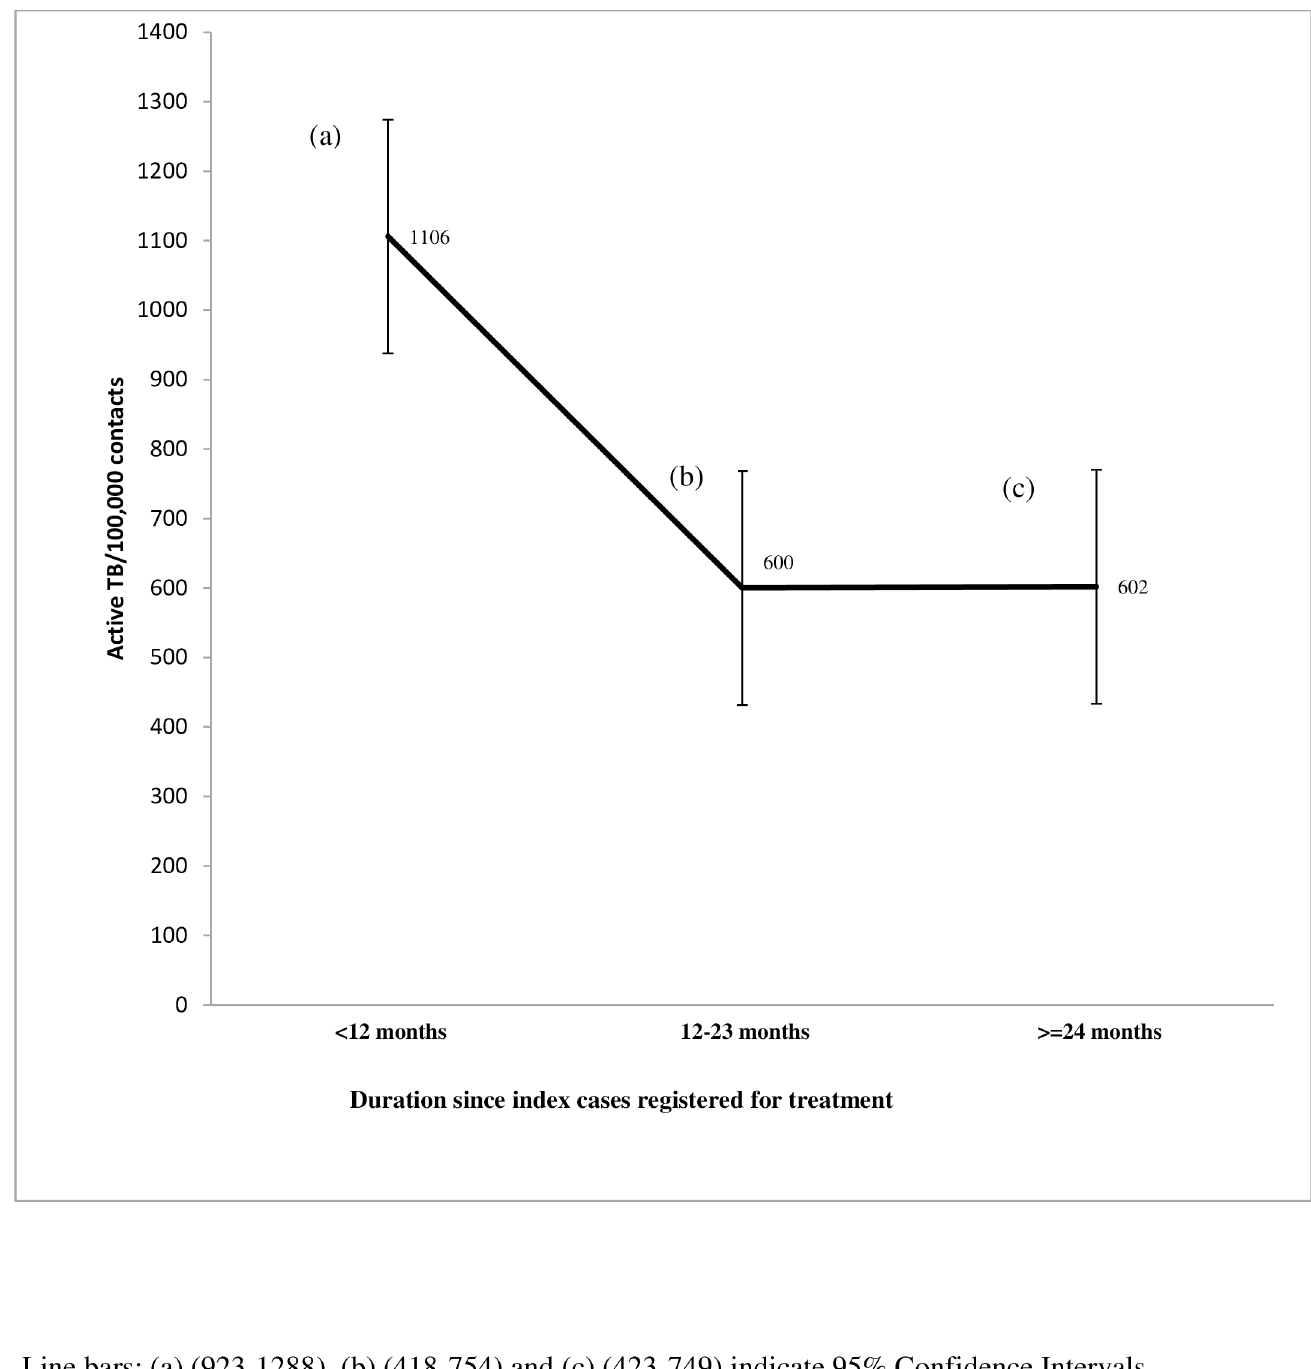
Fig 2. Yield per 100,000 contacts based on the time since index cases registered for TB treatment. doi:10.1371/journal.pone.0160514.g002 PLOS ONE | DOI:10.1371/journal.pone.0160514 August 2,